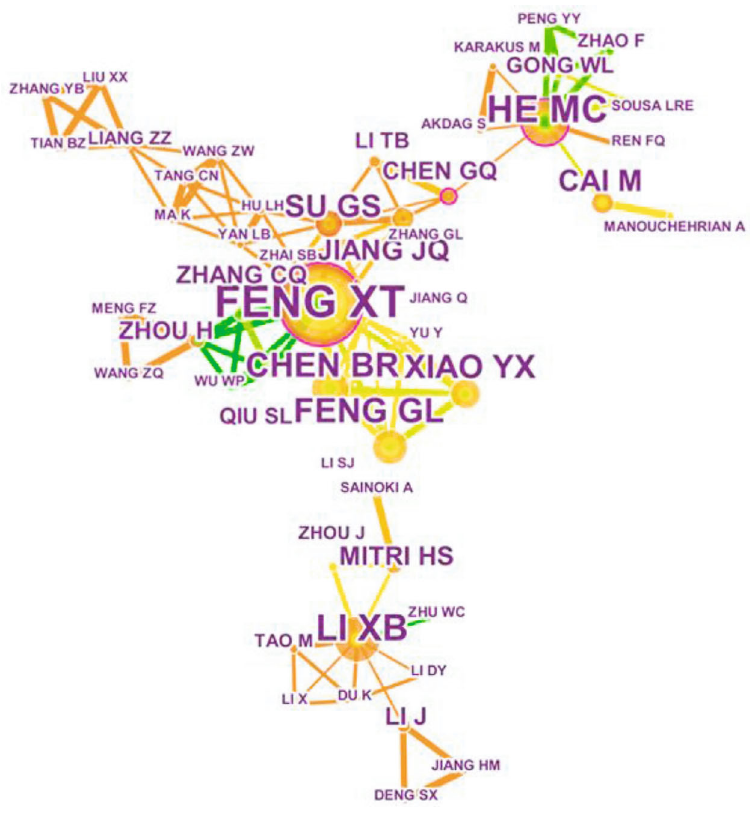
Figure 7: Author cooperation network.